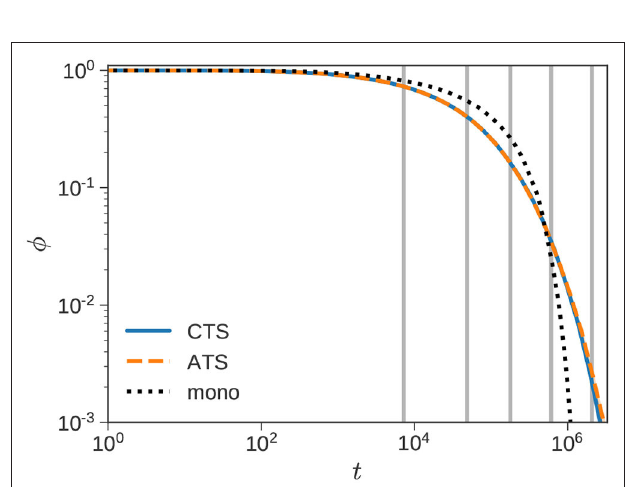
FIGURE 10 | Polydisperse sample. Normalized stress relaxation of a sample with ¯ Z w = 50, and polydispersity index of 1.2 using f = 8 fractions. Gray lines indicate complete relaxation of shorter components. The dotted line shows φ ( t ) of a monodisperse polymer with ¯ Z =